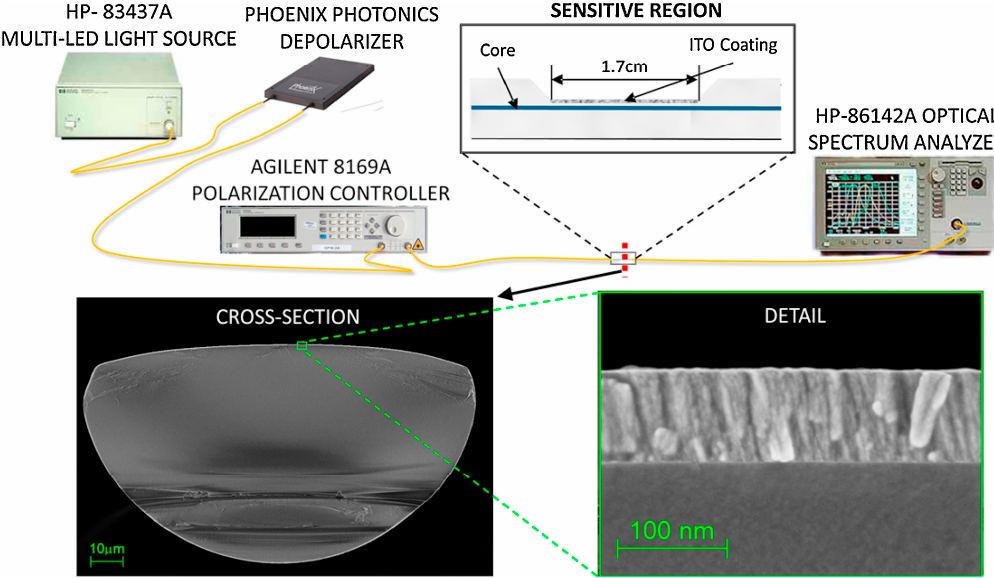
Figure 7. Example of LMR-based refractometer using a D-shaped fiber. A 17-mm long segment of side-polished single-mode fiber (SMF) was coated with an ITO thin film. The geometry of this structure can be appreciated in the cross-section image obtained by SEM. Reprinted from [16] with permission from Elsevier.